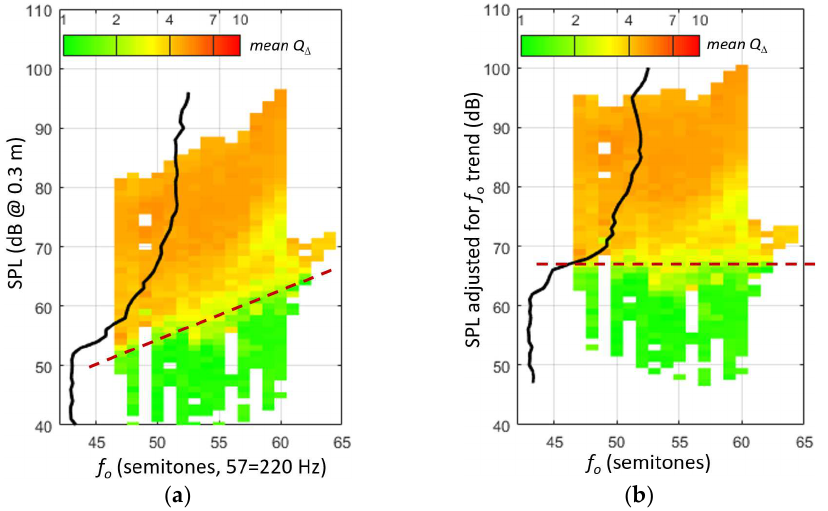
Figure 2. ( a ) A map of an exemplary metric Q ∆ (the per-cycle-normalized peak derivative of the EGG signal), typically skewed with increasing f o . The black line shows the average of Q ∆ taken horizontally over all semitones. Its abscissa is the vertical SPL axis; its ordinate is on the horizontal color bar. ( b ) The same map with the dependency on f o was removed by adjusting the SPLs so as to make the dashed trend line horizontal. The increase in Q ∆ is now more sharply focused, on the scale of adjusted SPL.